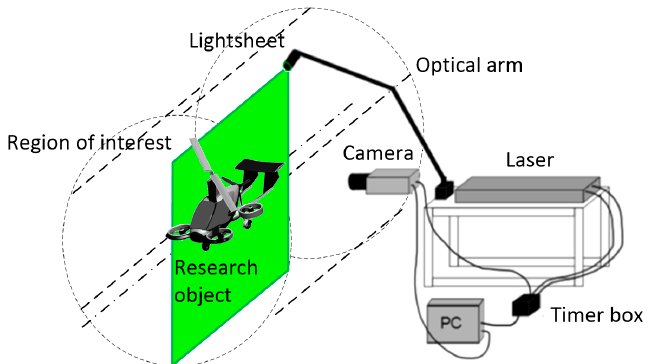
Figure 6. Diagram of the test stand for visualization of the flow around the research object (own study based on Reference [37]).